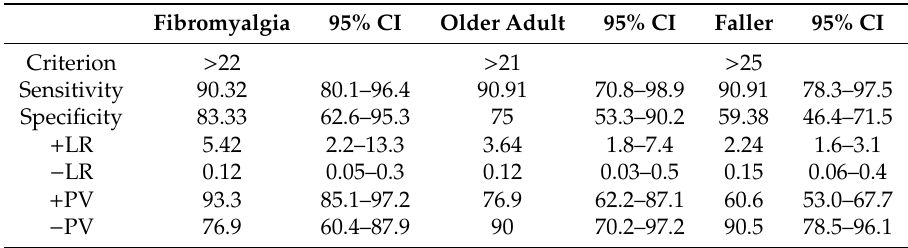
Table 7. Capacity of the 20-item JAEN screening tool to discriminate between patients and controls: cut-o ff points and their predictive values. Fibromyalgia 95% CI Older Adult